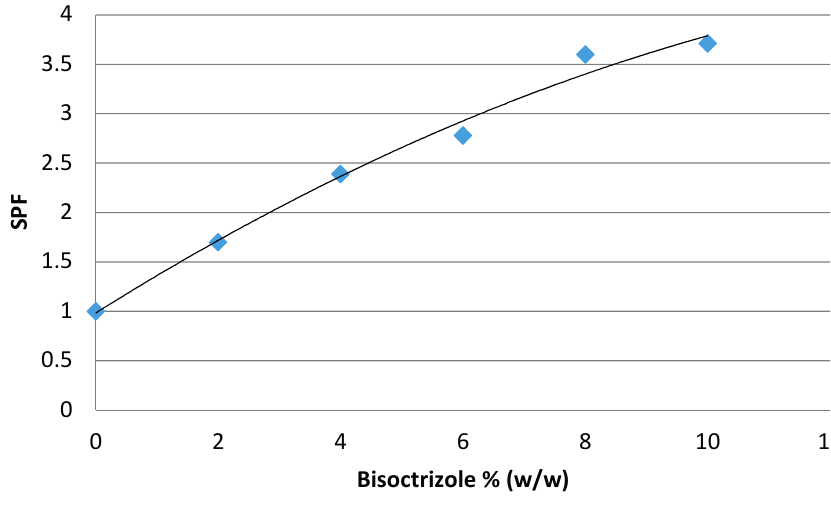
Figure 1. Efficacy of bisoctrizole in the UVB